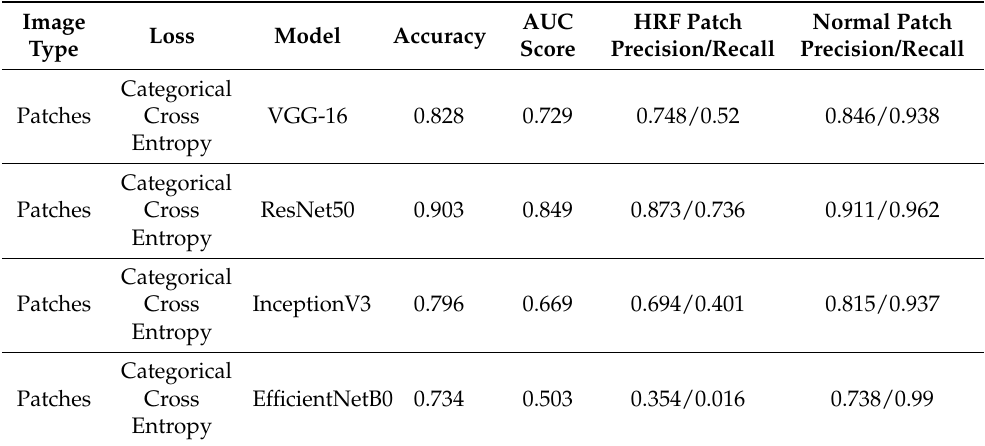
Table 1. Training and testing on B-Scans using (4) models for patch image type.